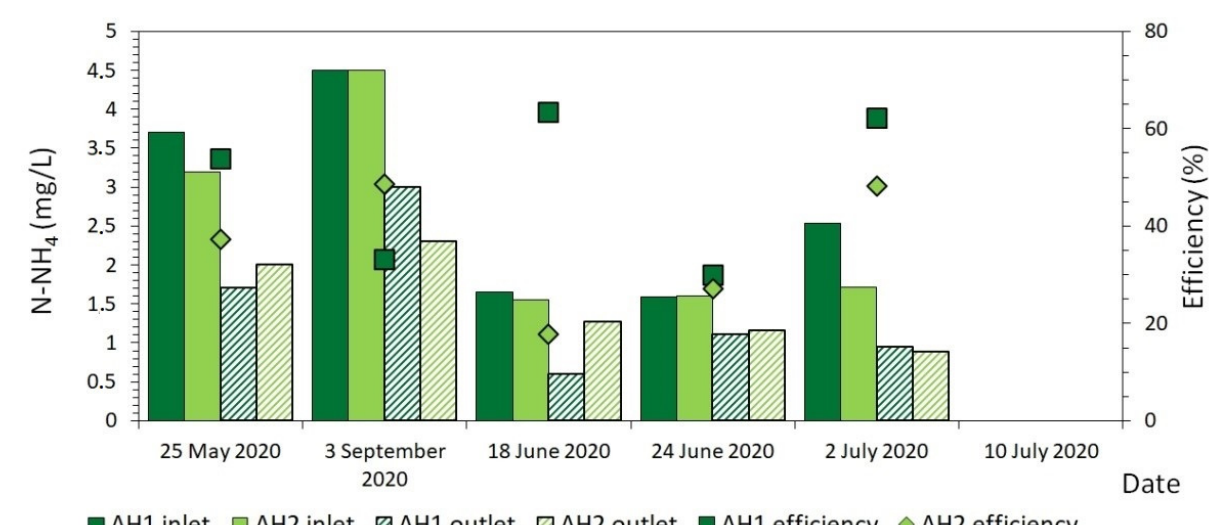
Figure 9. Inlet and outlet N NH4 and removal efficiencies at stage II.